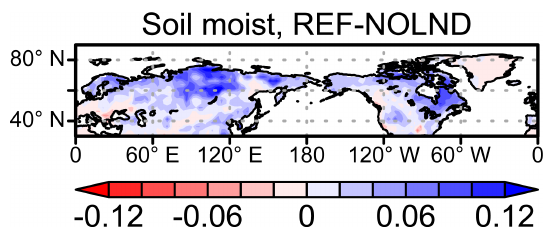
Figure 10. Impact of the land surface model update (the REF run minus the NOLND run) on the simulated soil moisture at the up- permost land surface model level. Simulations using NICAM16-7S were performed for 4 years, and June–July–August data for the last 3 years are averaged. The data are gridded at 2.5 ◦ in longitude and